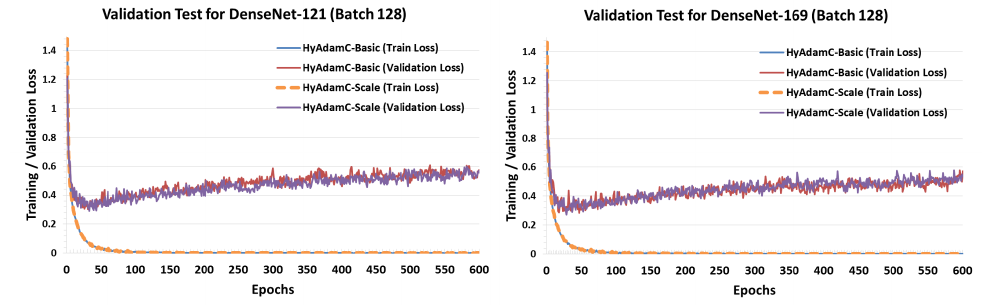
Figure 28. The training and validation loss curves of HyAdamC-Basic and HyAdamC-Scale in DenseNet. The left and right plots shows the loss curves of HyAdamC evaluated in DenseNet-121 and 169, respectively.